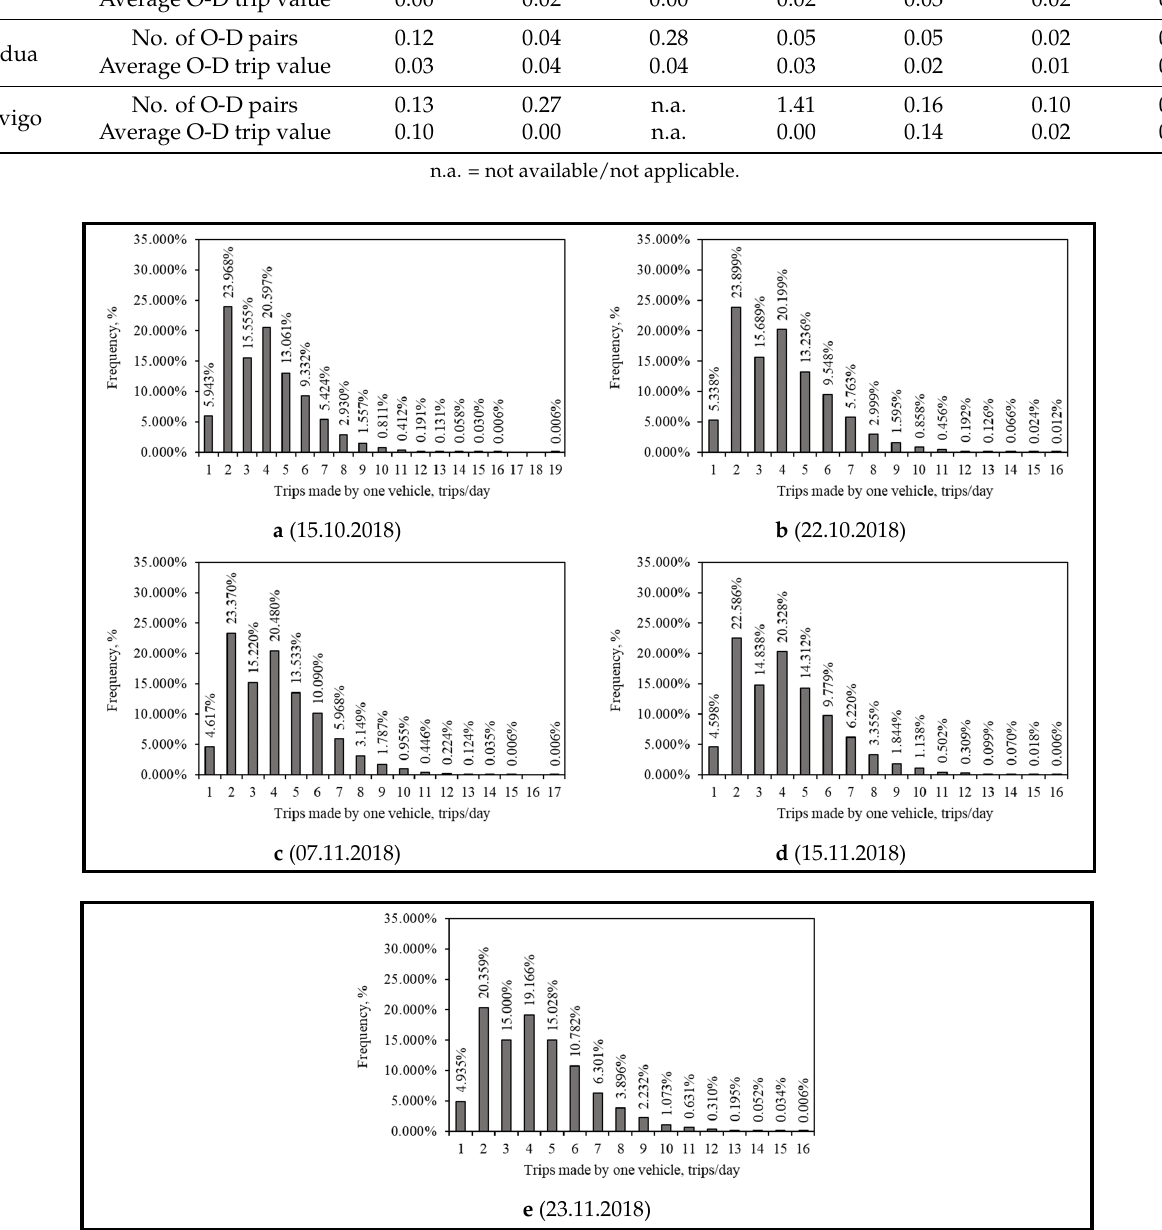
Figure 6. Distribution of daily trip number made by sampled vehicles. Table 6. Basic statistical attributes of trip chains.